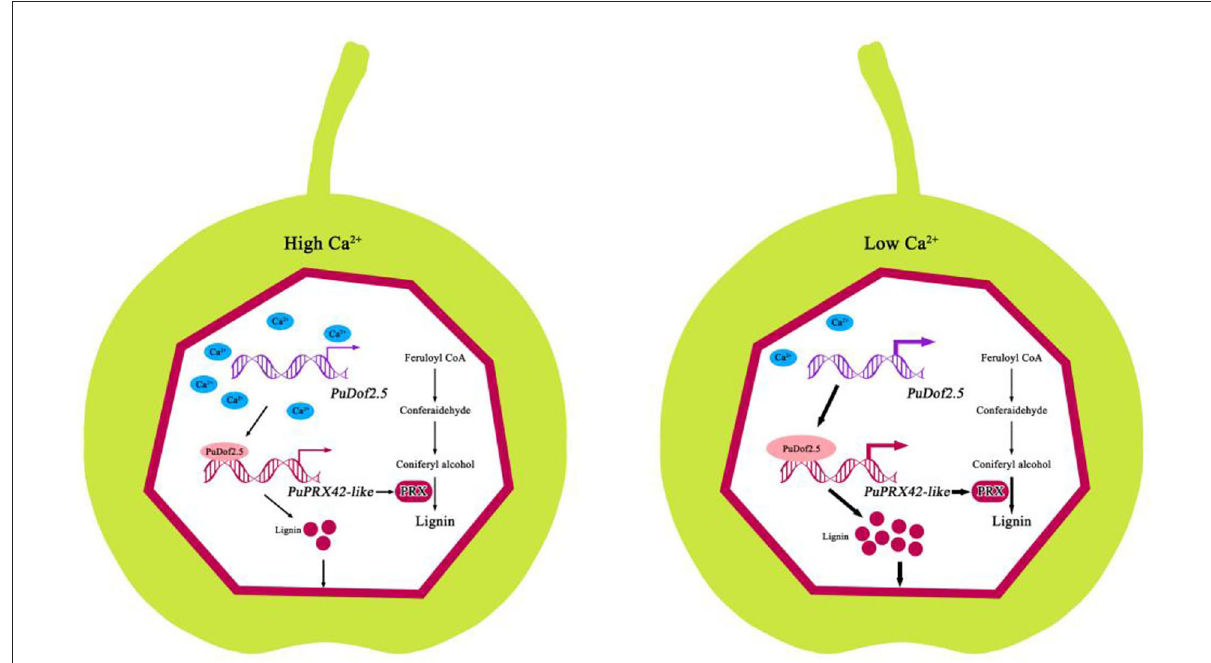
FIGURE7 Model of the mechanism by which Ca 2 + suppresses stone cell production in pear fruits. At high levels of endogenous Ca 2 + , PuDof2.5 downregulated the transcription of lignin biosynthetic gene PuPRX42-like by directly binding to the promoter, decreasing lignin accumulation and stone cell production. At low levels of endogenous Ca 2 + , PuDof2.5 upregulated the transcription of lignin biosynthetic s PuPRX42-like , increasing lignin accumulation and stone cell